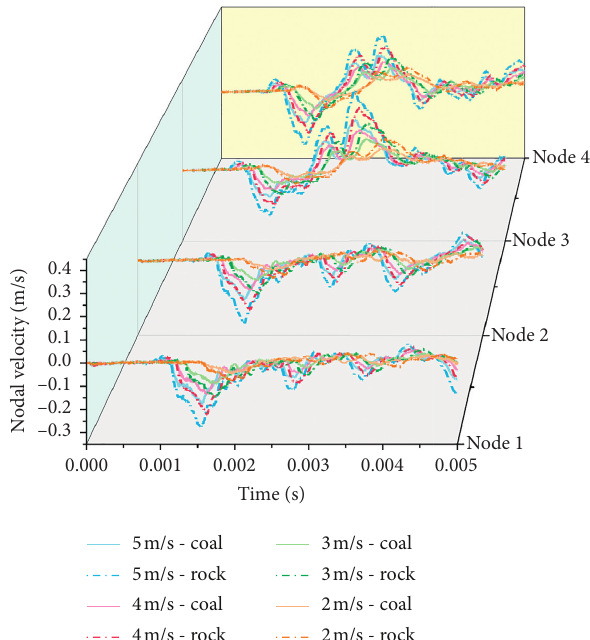
Figure 15: Nodal velocity in the tail beam noncollision contact zone under different impact speeds.